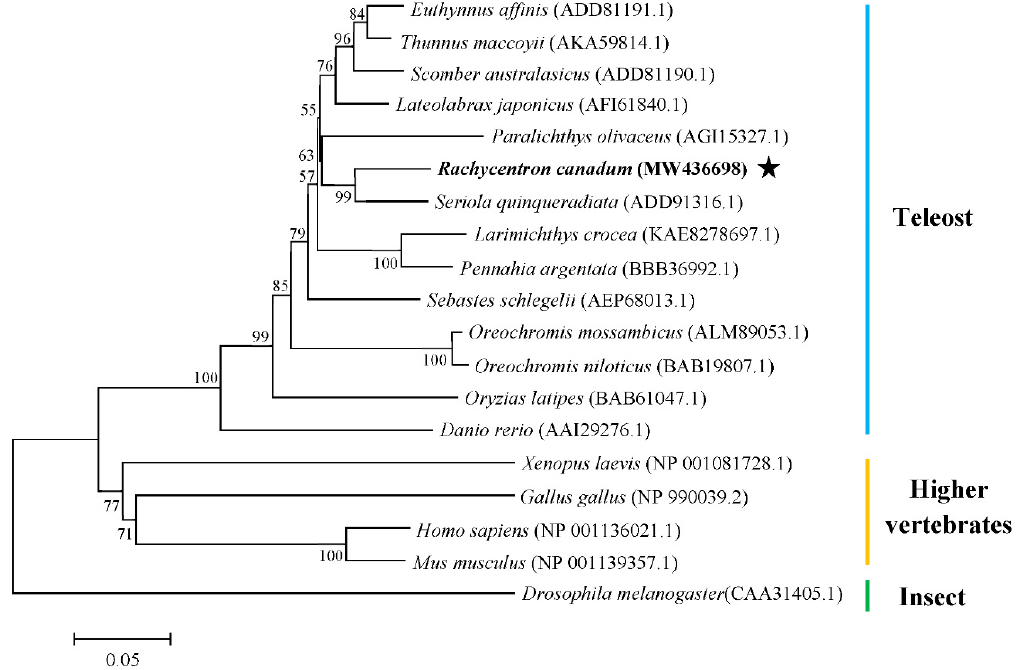
Figure 2. Phylogenetic tree of vasa amino acid sequences based on the Neighbor-Joining (NJ) method. The tree is based on a 1000 bootstrap procedure; the scale bar (0.05 in terms of genetic distance) is indicated below the tree; the asterisk indicates the target species in this study.